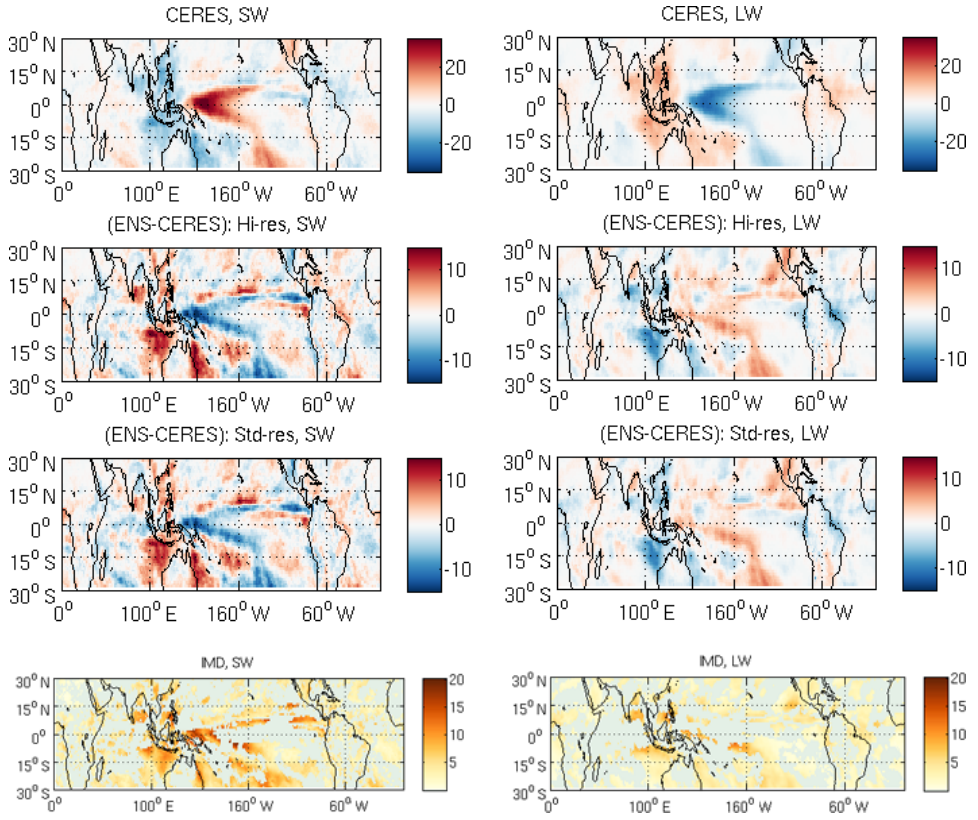
Figure 7. The SW (left) and LW (right) cloud radiative fluxes at the TOA as a response to negative phase of ENSO from top row: CERES- EBAF observations; second row: the ensemble mean Hi-res; and third row: Std-res model-simulated differences of this response from observations. Bottom row: the ensemble intermodel differences in Wm − 2 . The grey shaded areas are the regions where all the nine model setups do not agree with the sign of the